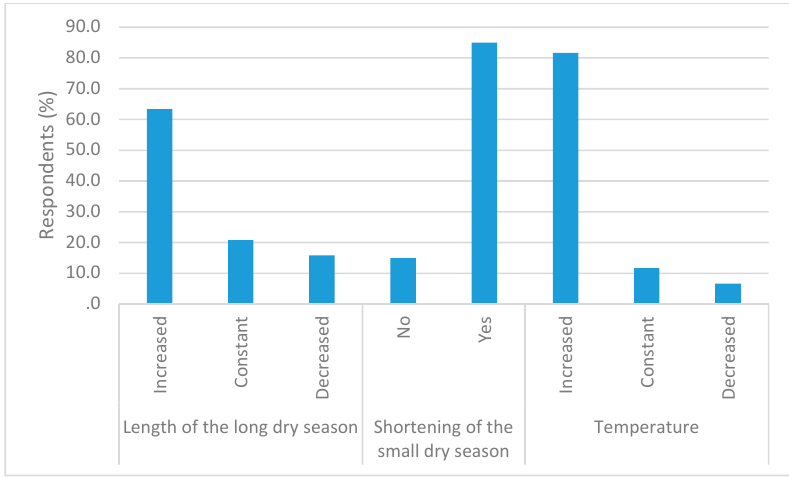
Figure 4. Farmers’ perception of changes in temperature and drought.